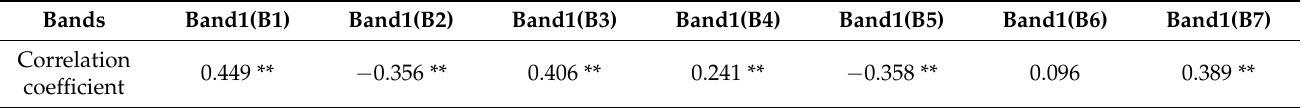
Table 1. Correlation between Terra MODIS bands and soil pH at sampling sites.